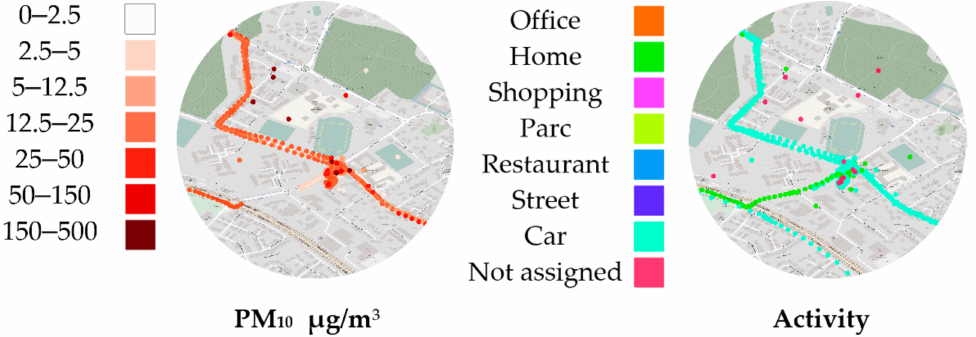
Figure 8. Point of interest for particulate matter (PM 10 ) B “Home” cluster with lack of GPS